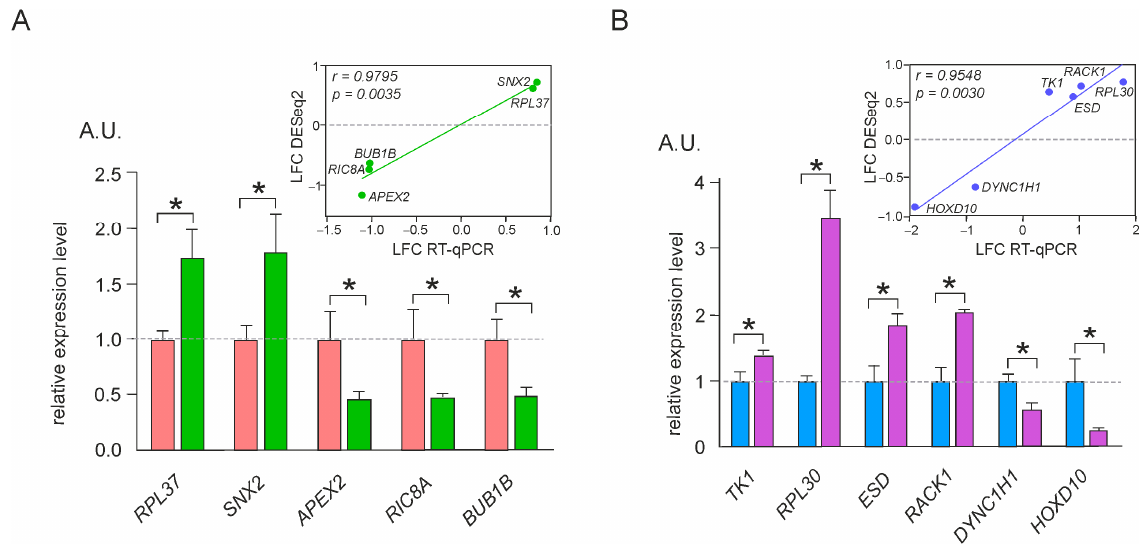
Figure 3. The validation of differential gene expression analysis by RT-qPCR. Data of the relative expression level for representative tDEGs ( A ) and pDEGs ( B ) in HEK293T cells, producing wt-uL15 3 × FLAG and mut-uL15 3 × FLAG , are presented as the mean ± SEM of arbitrary units (A.U.) from three biological replicates (* p < 0.05, Mann–Whitney test). Green ( A ) and pink ( B ) columns show the relative levels of gene expression in cells producing mut-uL15 3 × FLAG compared to the levels of gene expression in cells producing wt-uL15 3 × FLAG , which are shown in rose and blue columns, and taken as 1. The correlation between RT-qPCR and RNA-seq data is shown in the top